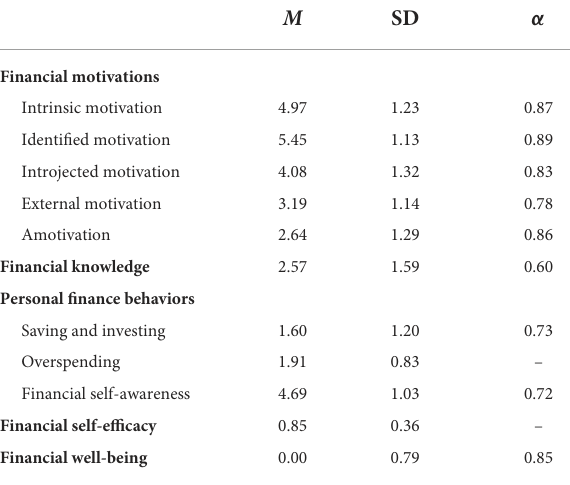
TABLE 2 Study 1 means, standard deviations, and internal reliabilities for study